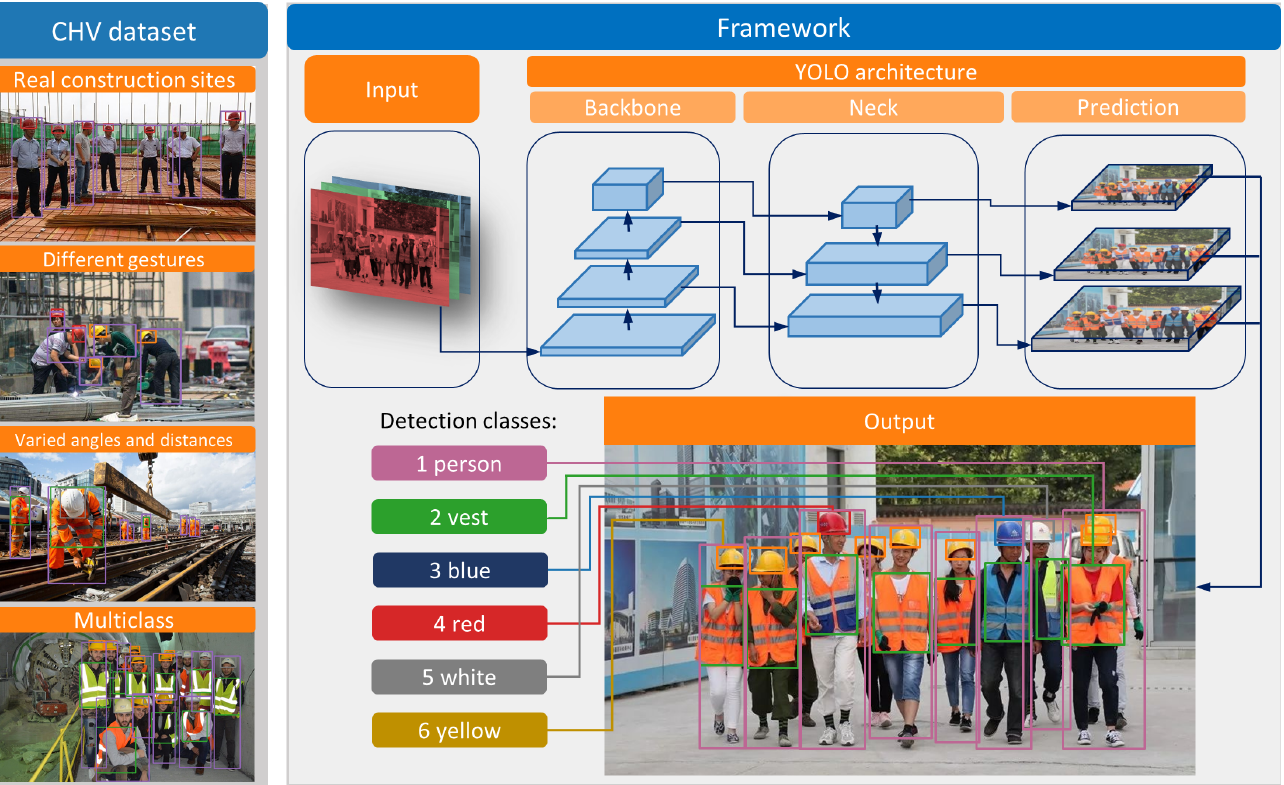
Figure 3. The proposed framework of PPE detection based on YOLO